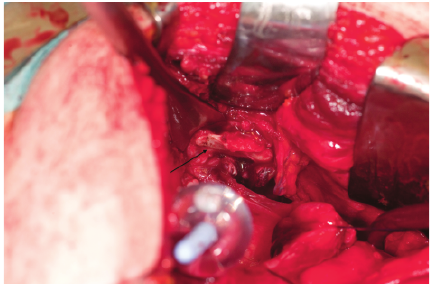
Figure 5: Open bladder with visible bone spur (black arrow).